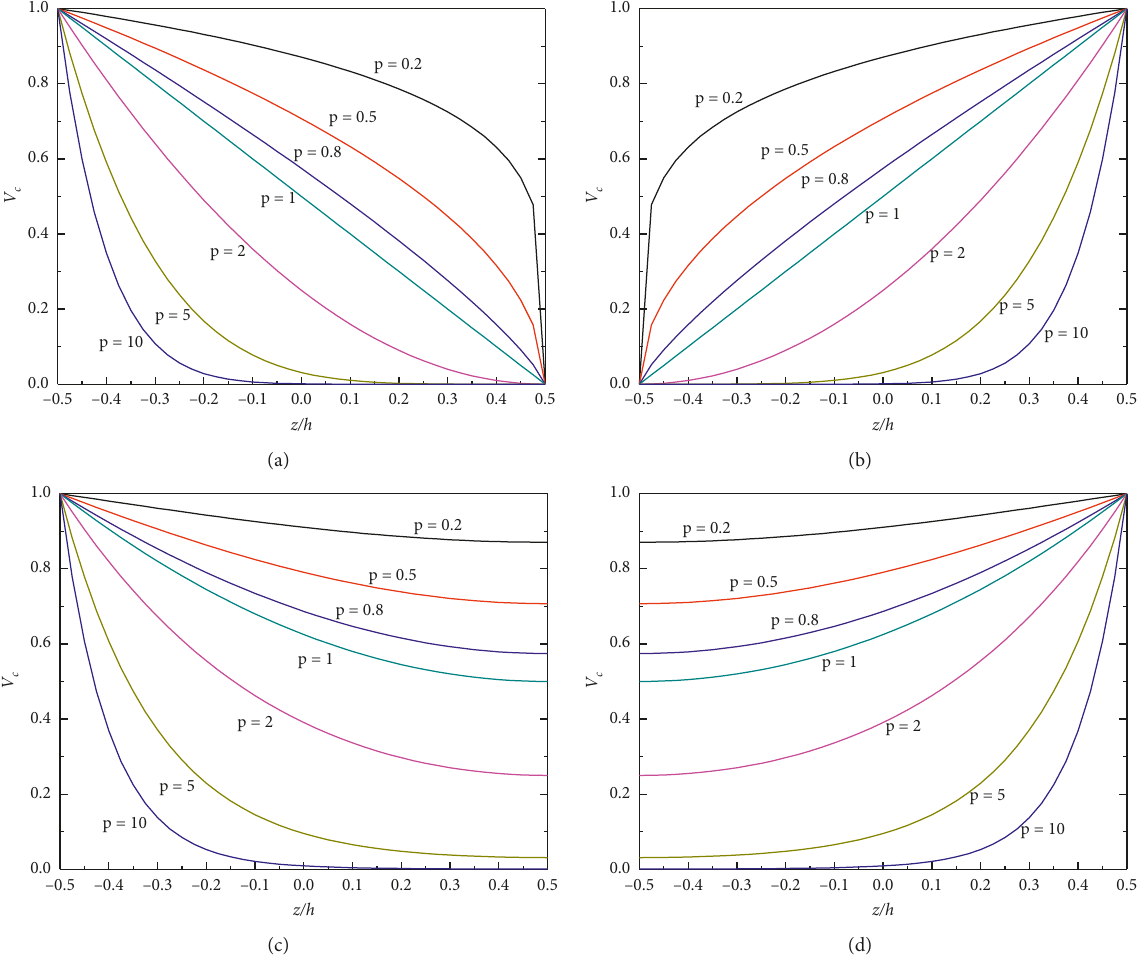
Figure 3: Variations of the volume fraction ( V c ) through the structure thickness for different values of power-law exponent p . (a) FGM I(a ; (b) FGM II(a ; (c) FGM I(a ; (d) FGM I(a (cid:29) 1/b (cid:29) 0/c/p) (cid:29) 1/b (cid:29) 0/c/p) (cid:29) 1/b (cid:29) 0.5/c (cid:29) 2/p) (cid:29) 1/b (cid:29) 0.5/c (cid:29) 2/p)